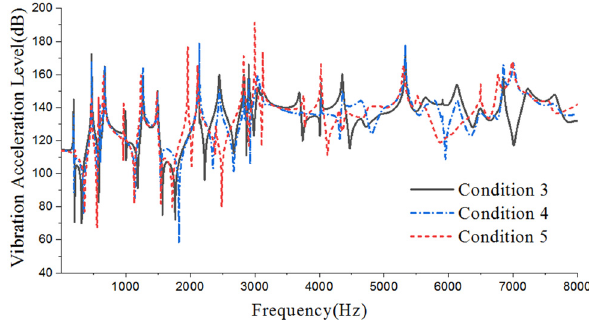
Figure 16: Vibration response of test points P 6 – P 8 for condi - tions 3 – 5.